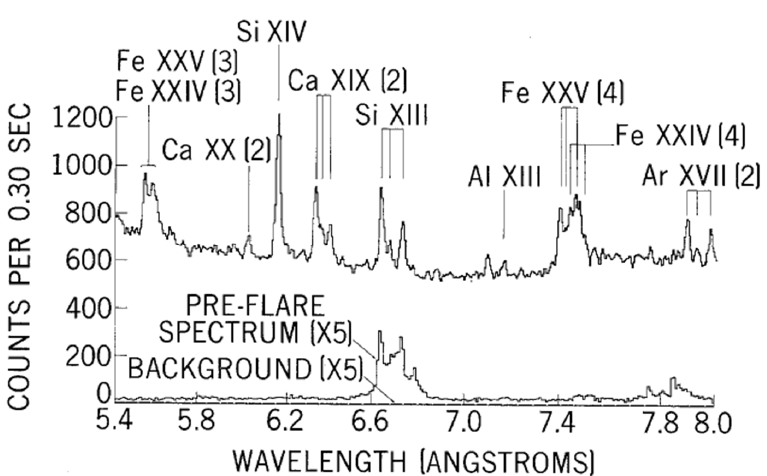
Figure 1. Solar flare spectrum obtained by crystal spectrometer on OSO-5.